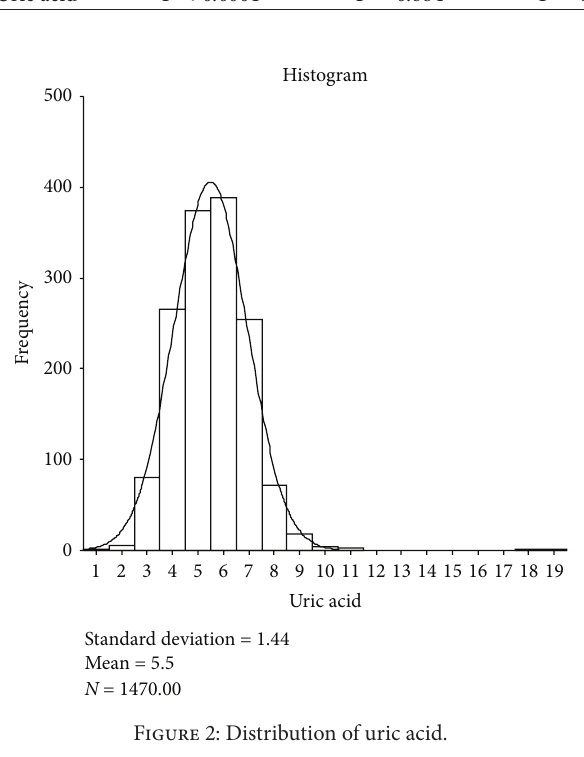
Figure 2: Distribution of uric acid.